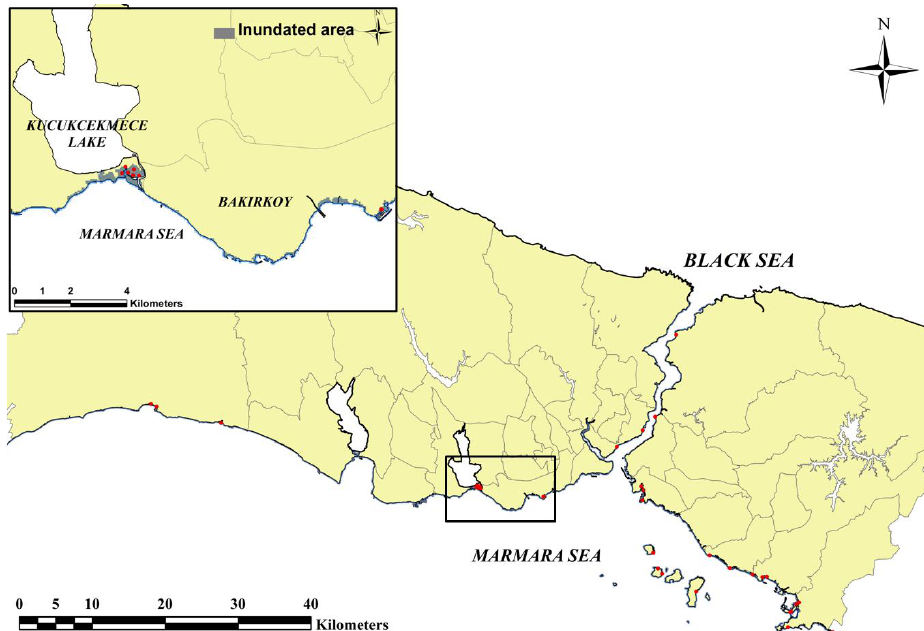
Figure 11. Spatial distribution of the infrastructure buildings at risk: Buildings highlighted by red. Embedded frame: A closer view of the 2 Fig. 11. Spatial distribution of the infrastructure buildings at risk: buildings highlighted in red. Embedded frame: a closer view of the inundated areas where most of the infrastructure buildings are located. 3 inundated areas where most of the infrastructure buildings are